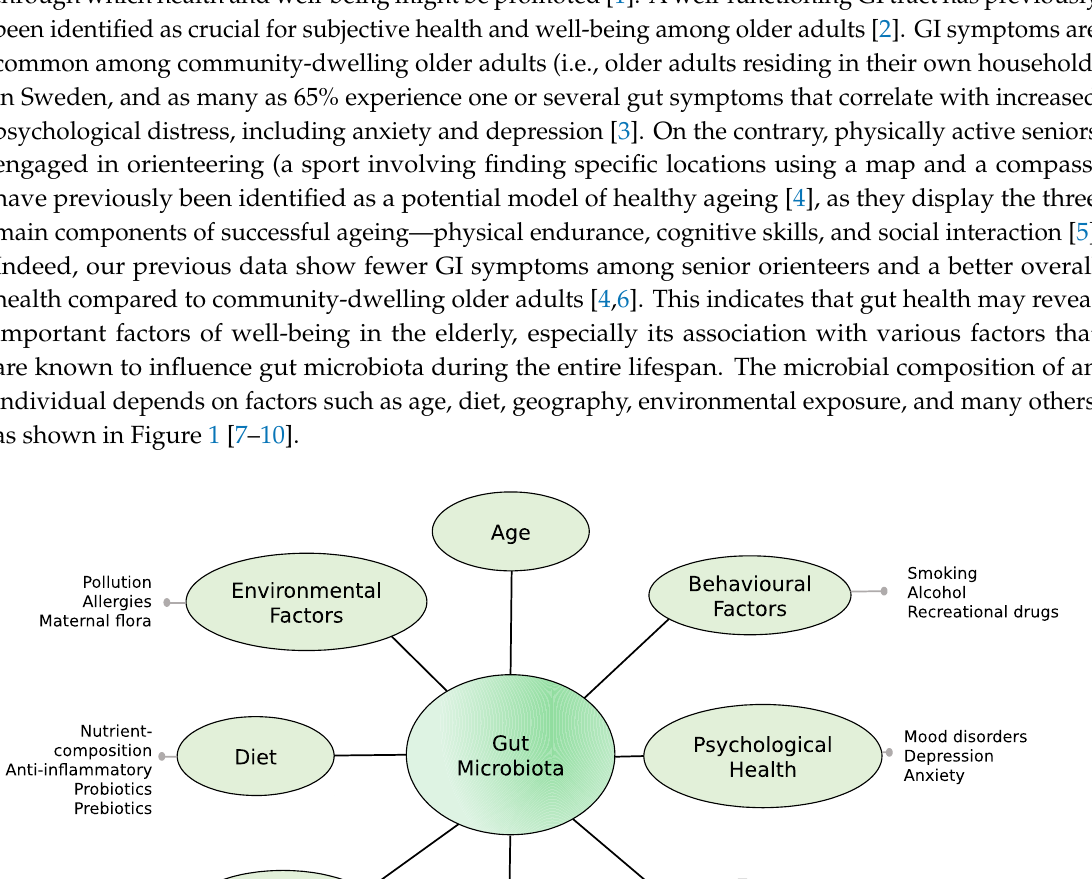
Figure 1. Factors affecting the composition of gut microbiota.